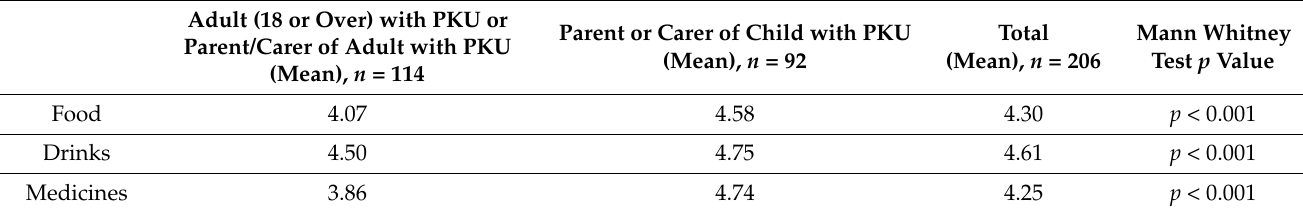
Table 3. Mean levels of checking food, drink and medicine labels by age group.